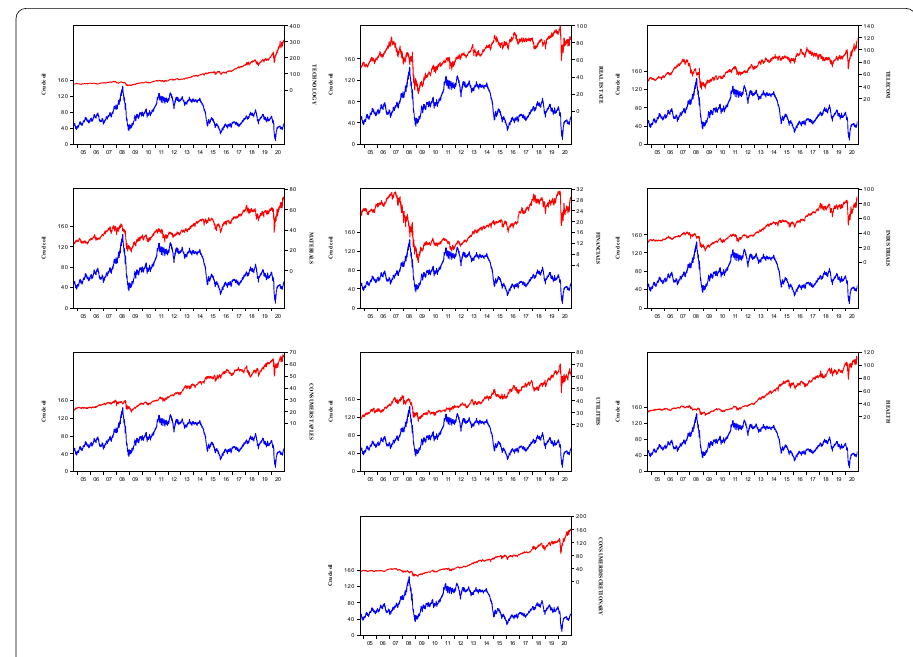
Fig. 1 Pairwise graphs between non-energy sector ETFs and crude oil prices